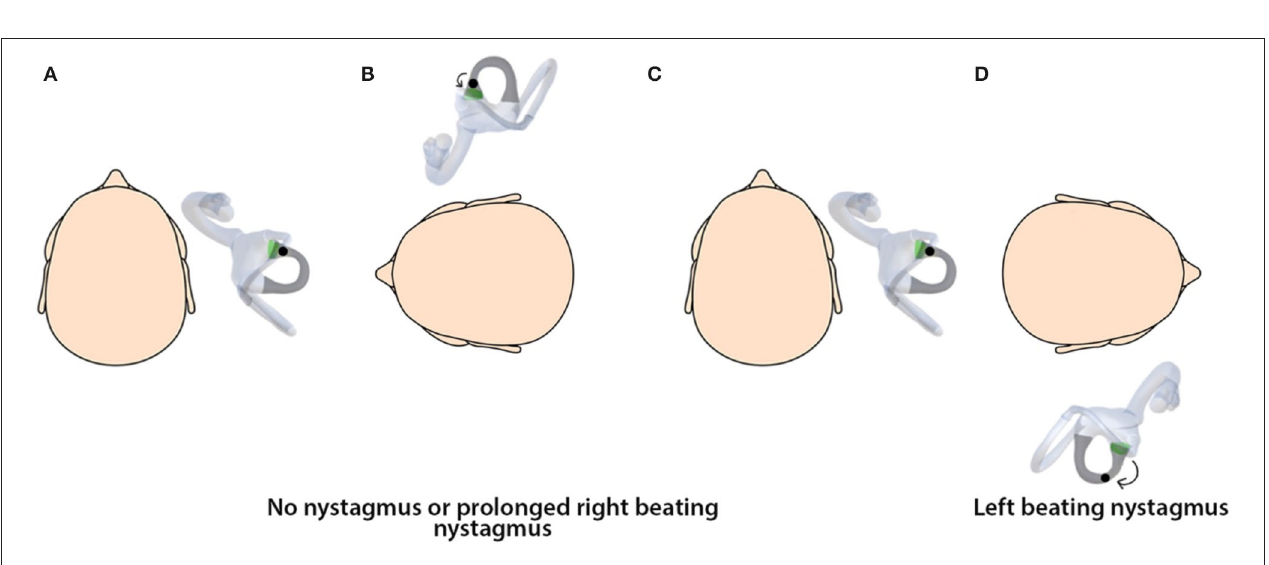
FIGURE 5 | (A) Horizontal canalithiasis of the ampullary arm right ear. (B) On turning the head to the left in the first step, there is little movement of the debris with no nystagmus elicited, or the debris may exert force on the cupula, leading to generation of prolonged right-beating nystagmus. (C) The head is turned to the center. (D) On turning the head to the right, there is left-beating